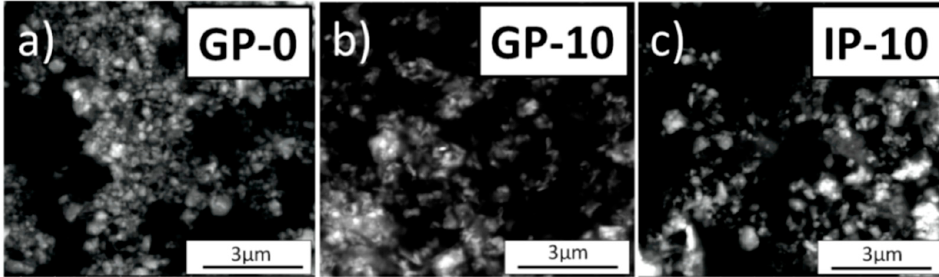
Figure 2. SEM micrographs of: ( a ) GP-0, ( b ) GP-10 and ( c ) IP-10 powders obtained by calcinating the precursor gel for 2 h in air at 1073 K.